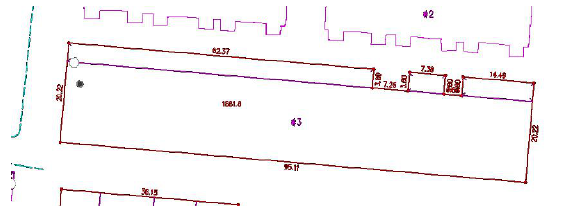
Figure 8 The partial results of cadastral map.